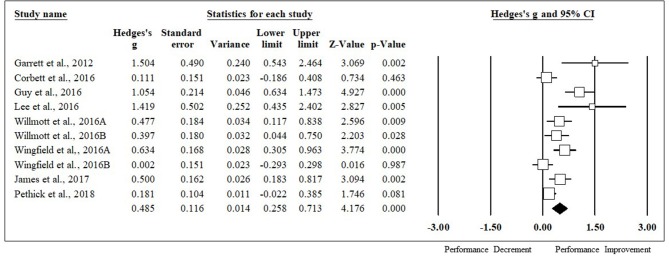
Time trial forest plot. Data are presented as Hedge's g and 95% confidence intervals.